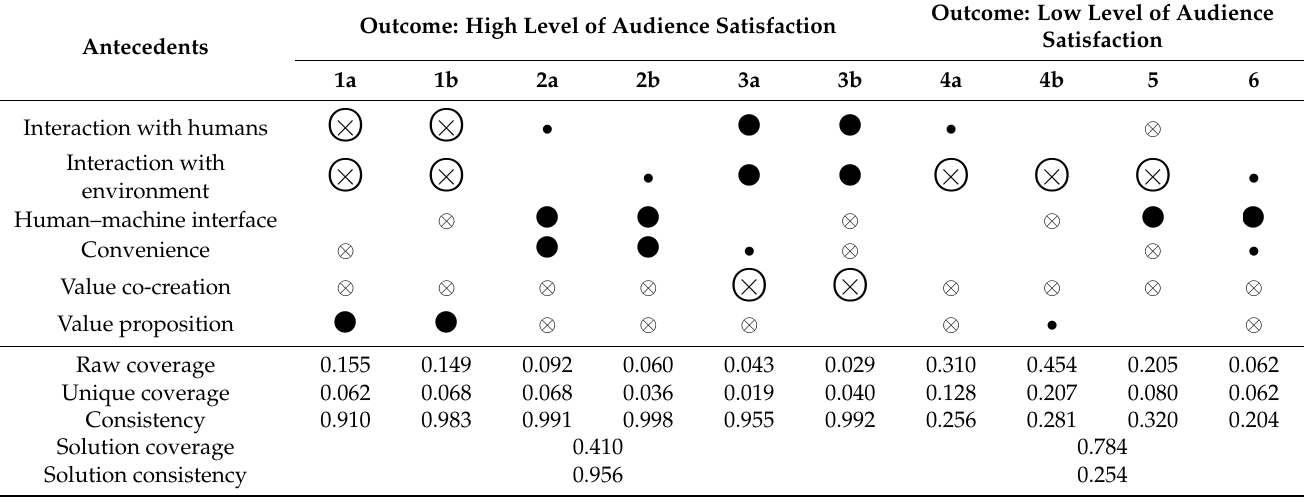
Table 8. Configurations strongly related to audience satisfaction.